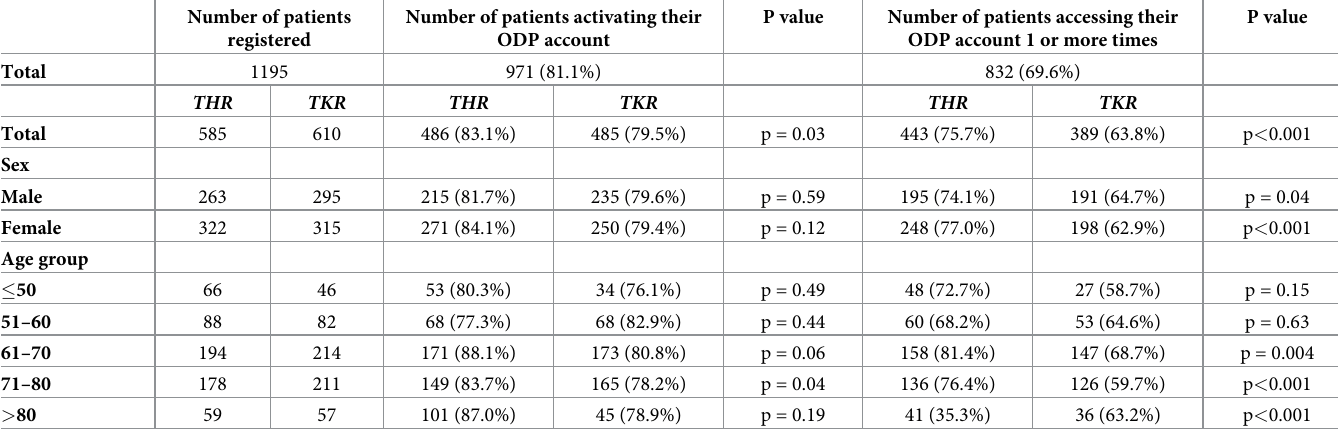
Table 1. Summary of number of patients registered, activated and accessed dependent on type of surgery, sex and age.